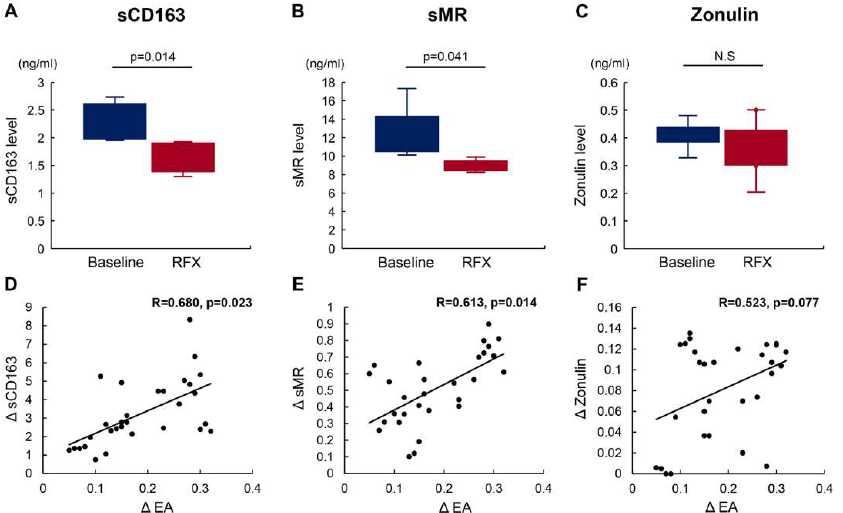
Figure 3. Effect of rifaximin on serum soluble mannose receptor (sMR), sCD163, and zonulin level. ( A – C ) Rifaximin decreased the serum levels of sCD163 ( A ) and sMR ( B ) but did not alter serum zonulin levels ( C ). ( D – F ) Univariate correlation analyses revealed that the decrease in the endotoxin activity level after treatment with rifaximin (ΔEA) positively correlated with the decreases in the serum sCD163 ( D ) and sMR levels ( E ). The decrease in the serum zonulin levels (Δzonulin) showed a marginally positive correlation with ΔEA ( F ). Data are means ± SD.